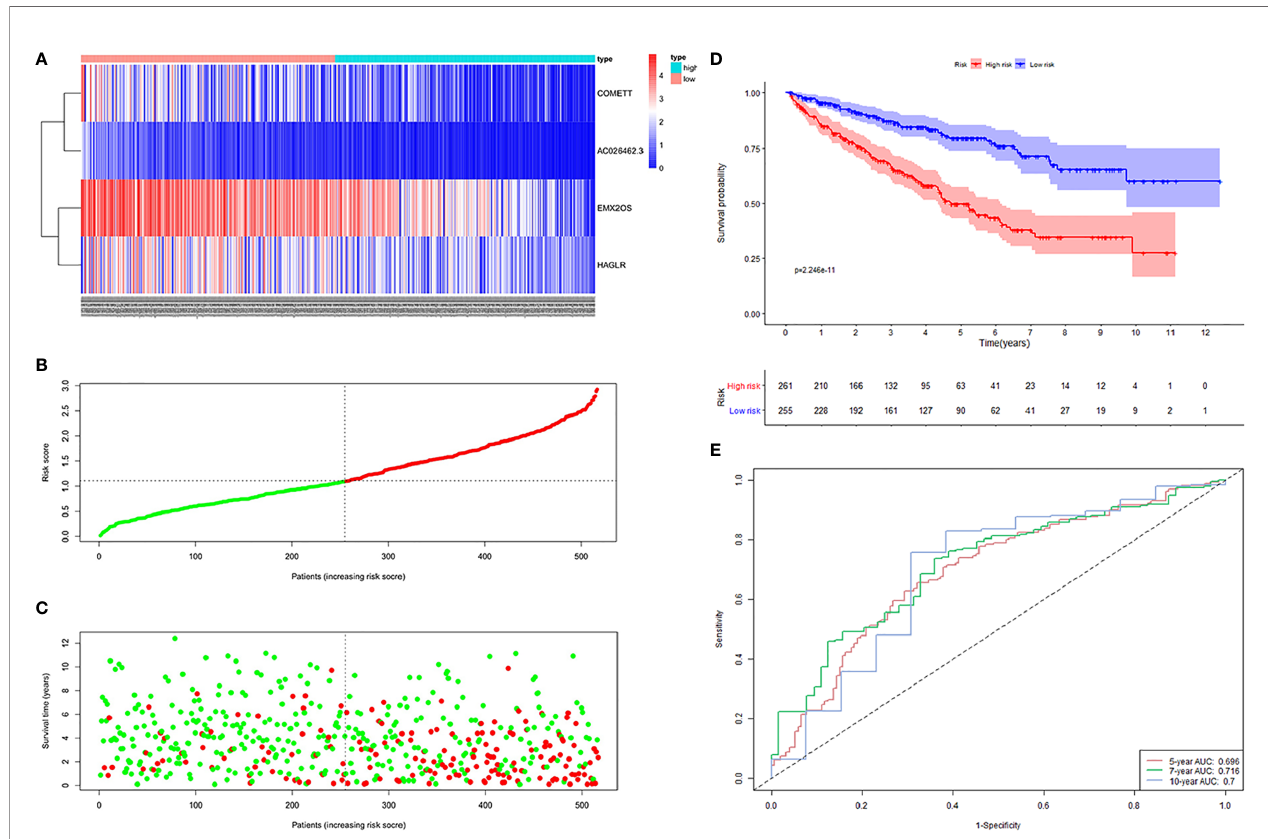
FIGURE 5 | Four hypoxia-related lncRNA signature validated in entire cohort (n = 516). (A) Expression values of the four-signature lncRNAs. The colors from red to blue correspond to the expression of a lncRNA from high to low. The risk score (B) and survival status (C) of each ccRCC patient distributed in low- and high-risk groups. (D) KM survival analysis between the high-risk group and low-risk group. The lower layer demonstrates the number of alive ccRCC patients in each group. (E) Time-dependent ROC curves of the signature.